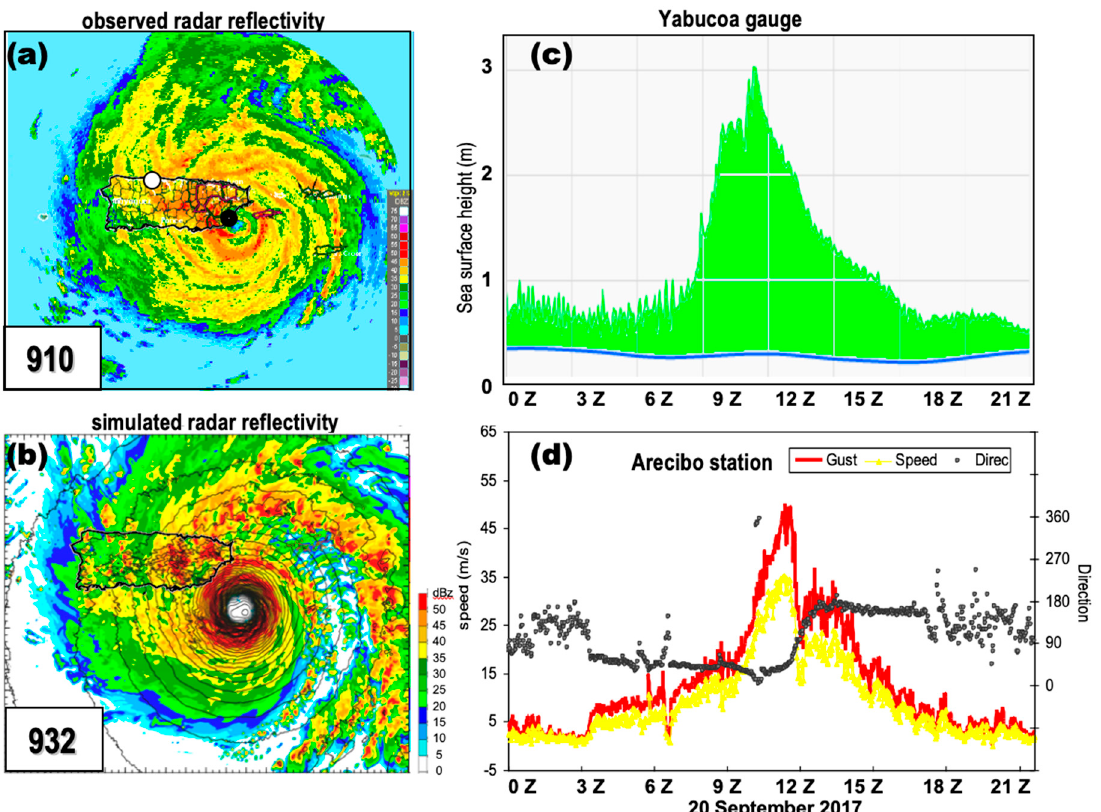
Figure 9. Maria Puerto Rico (PR) landfall 10Z 20 September 2017 maps of: ( a ) National Weather Service (NWS) radar reflectivity with central pressure labeled, ( b ) PR-area WRF simulated radar reflectivity and isobars (contour). Temporal records: ( c ) Sea surface height at Yabucoa harbor (closed dot in a), and ( d ) wind at Arecibo harbor (open dot in a); both with the same time axis.